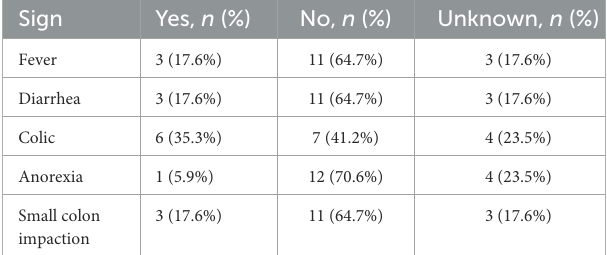
TABLE 4 Clinical signs of affected animals ( n = 17). TABLE 5 Univariate analysis identifying risk factors for being positive on fecal PCV for